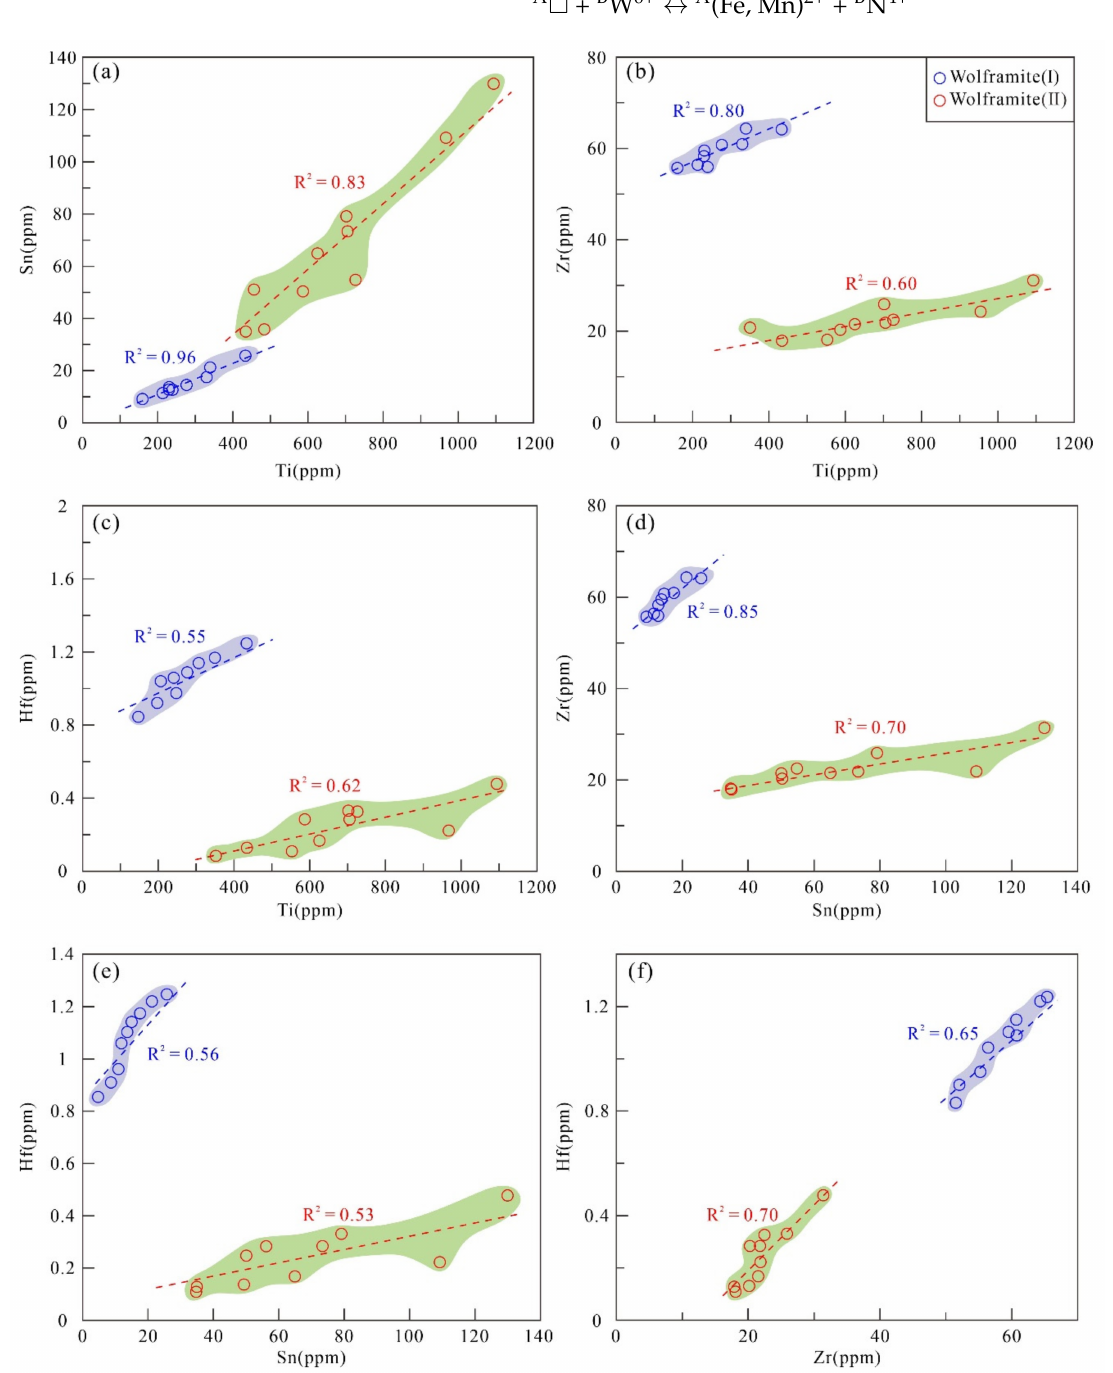
Figure 14. Tetravalent cations correlation plots for two generations of wolframite from the Baishi- touwa deposit. ( a ) Correlation plots of Ti and Sn contents; ( b ) Correlation plots of Ti and Zr contents; ( c ) Correlation plots of Ti and Hf contents; ( d ) Correlation plots of Sn and Zr contents; ( e ) Correlation plots of Sn and Hf contents; ( f ) Correlation plots of Zr and Hf